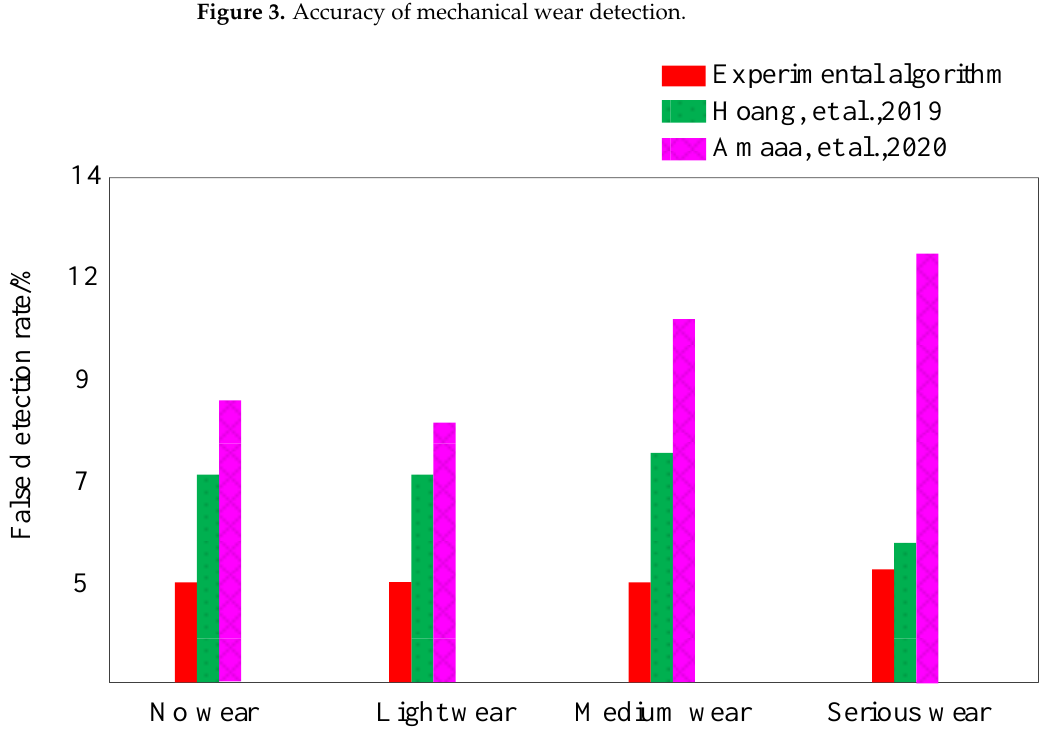
Figure 4. False detection rate of mechanical wear.